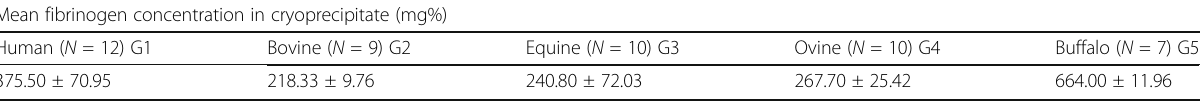
Table 2 Comparison of fibrinogen concentration in mg% in human, bovine, equine, ovine and buffalo blood Mean fibrinogen concentration in cryoprecipitate (mg%) Human ( N = 12) G1